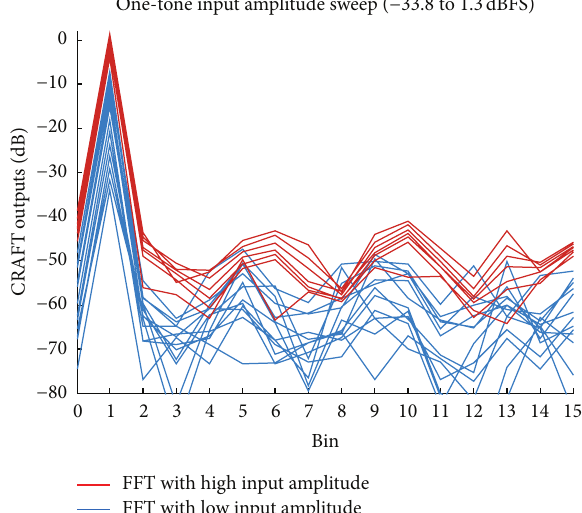
Figure 21: Measured frequency domain outputs of the 16 bins with an input on bin 1 at different input amplitudes showing noise in the other bins at low amplitudes (blue, thin) and nonlinearity at higher amplitudes (red, thick).